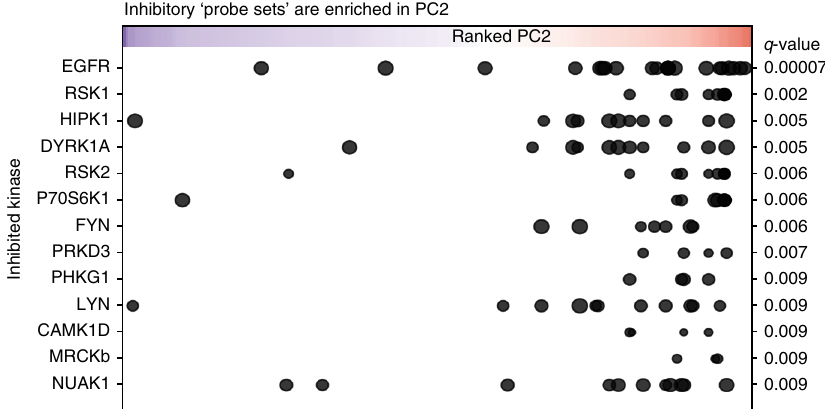
Fig. 4 GSE analysis identi fi es kinases targeted by probes leading to epidermal differentiation. Summary plot of GSE analysis of probes in PC2 shows expressed inhibited kinases ordered according to the signi fi cance of enrichment ( p -values (FDR) < 0.01, Supplementary Fig. 22). Probes (points in the graph) are ranked according to PC2 ( x -axis), and point size shows % of inhibition for the indicated kinase by